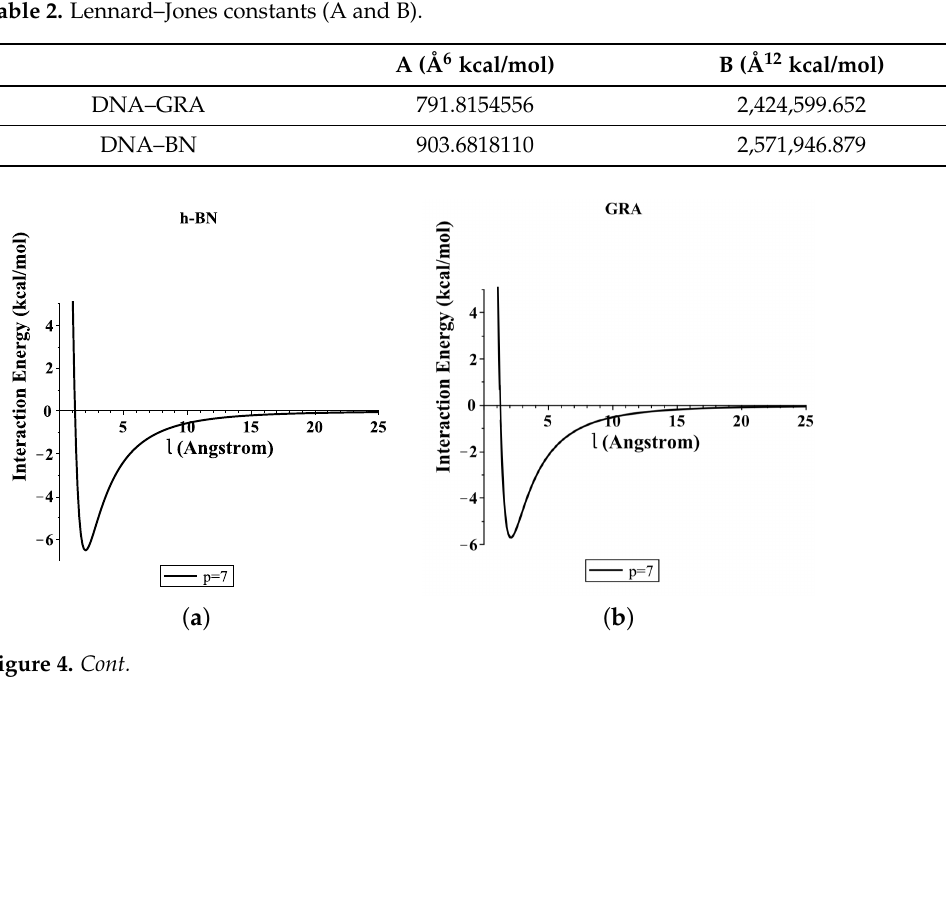
Table 2. Lennard–Jones constants (A and B).